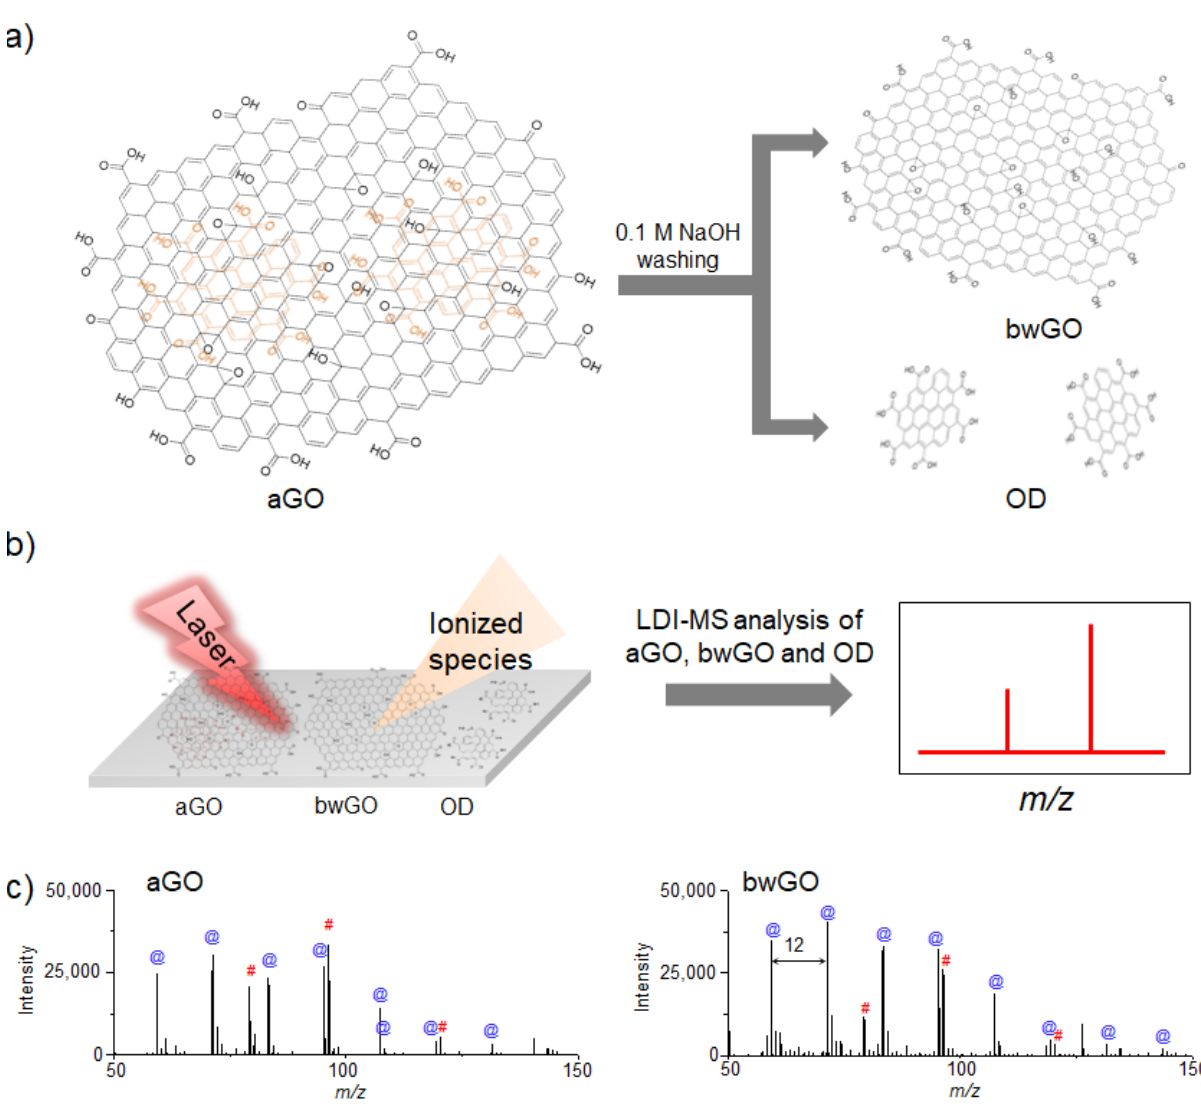
Figure 2. Schematic diagrams of ( a ) the separation process of OD and bwGO from aGO by washing with 0.1 M NaOH, and ( b ) LDI-TOF-MS analysis process of the obtained aGO and bwGO. ( c ) LDI-TOF-MS spectra of aGO and bwGO. The symbol @ in blue color corresponds to the carbon cluster ions and the symbol # in red color corresponds to the oxidized carbon cluster ions. Adapted from ref. [66] with permission from The Royal Society of Chemistry.